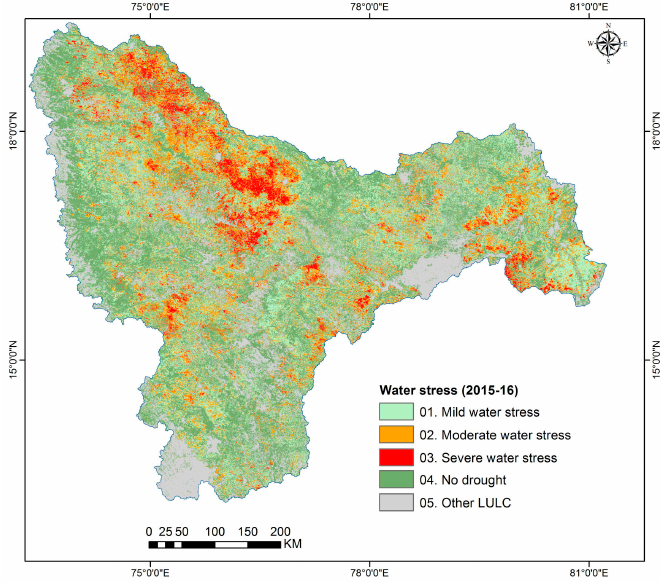
Figure 7. Spatial distribution of water stress during 2015–2016 (derived from 2015–2016 MODIS composite).